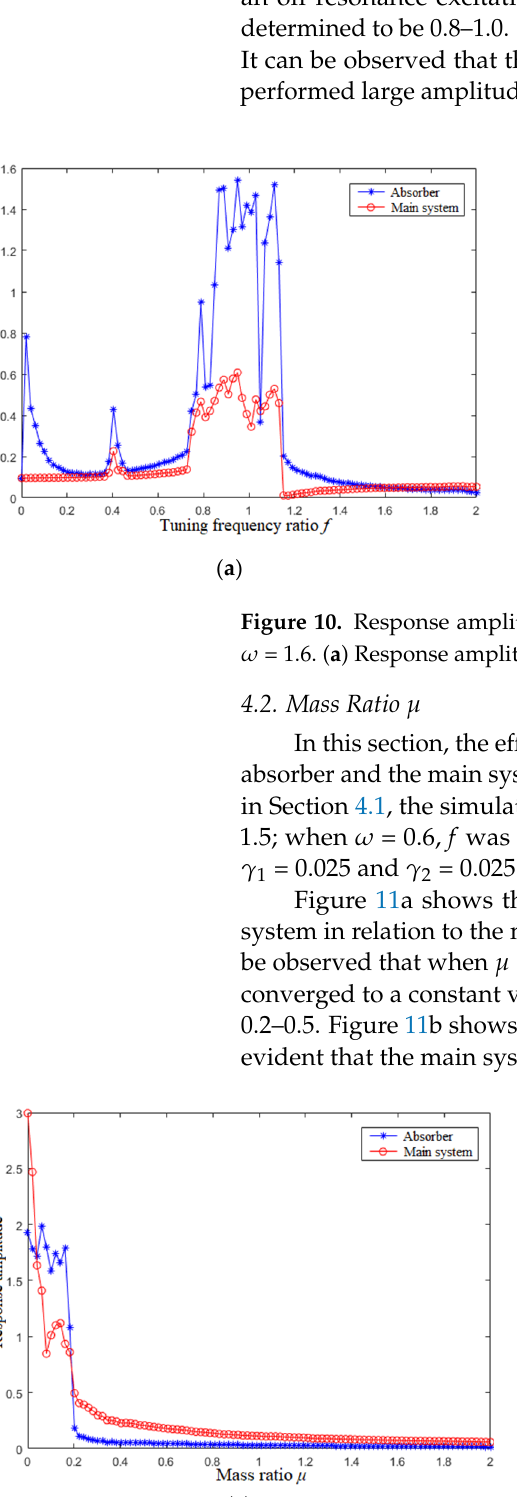
Figure 9. Response amplitude and phase diagram of two vibrators in the case of off-resonance ω = 0.6. ( a ) Response amplitude; ( b ) Phase diagram ( f = 0.5).